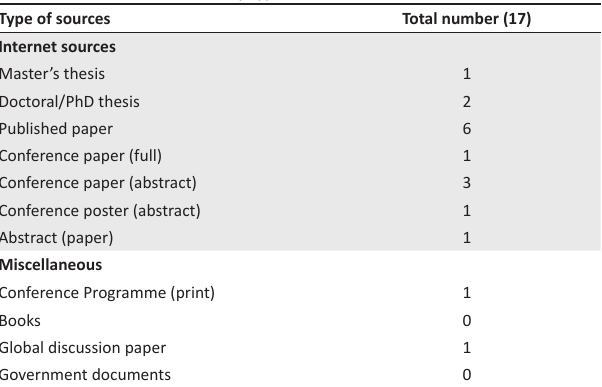
FIGURE 1: Preferred Reporting Items for Systematic Reviews and Meta-Analyses Extension for Scoping Reviews flow chart for the mapping review of knowledge about workers’ hearing when exposed to ototoxic chemicals with/without noise in literature focussed on South TABLE 3: Data items classified by type.